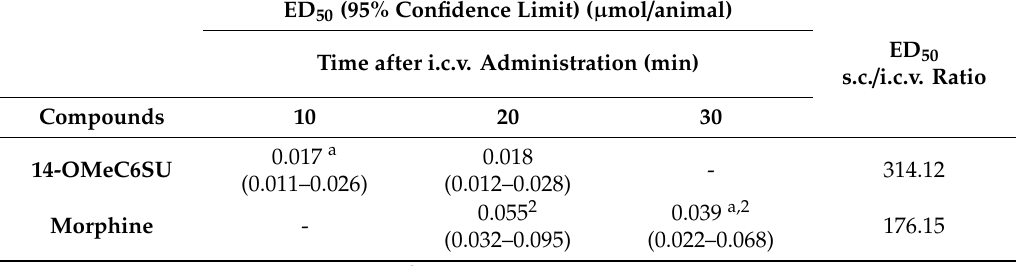
Figure 5. The antinociceptive effect (see Tables 3 and 4) of 14-OMeC6SU, compared to C6SU codeine and morphine in rat tail-flick test after s.c. ( A ) and i.c.v. ( B ) administration. Data represent means ± S.E.M. Table 7. Antinociceptive potencies (ED 50 ) of 14-OMeC6SU against radiant heat induced nociception in rat tail-flick test after 10, 20 and 30 min of i.c.v. administration. As a reference compound morphine was also indicated. The calculated s.c. / i.c.v. ratio of ED 50 values from Table 6 are also indicated. ED 50 (95% Confidence Limit) ( µ mol /